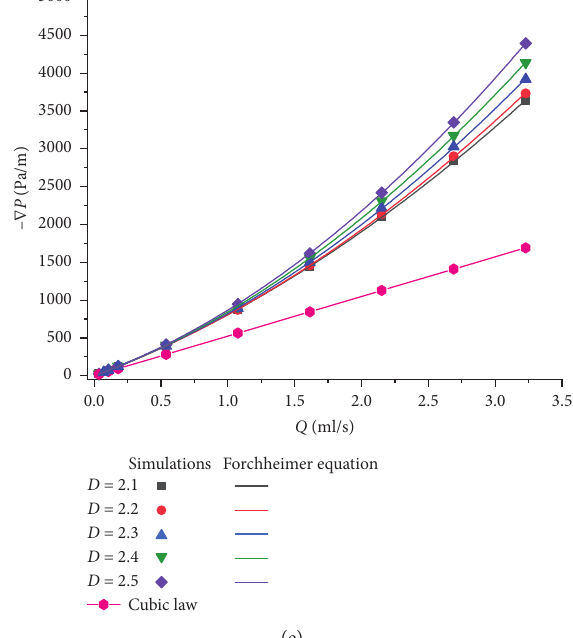
Figure 4: Relationship between flowrate and pressure gradient. (a) δ � 0.09mm. (b) δ � 0.12mm. (c) δ � 0.15mm. (d) δ � 0.18 mm. (e) δ � 0.21mm.